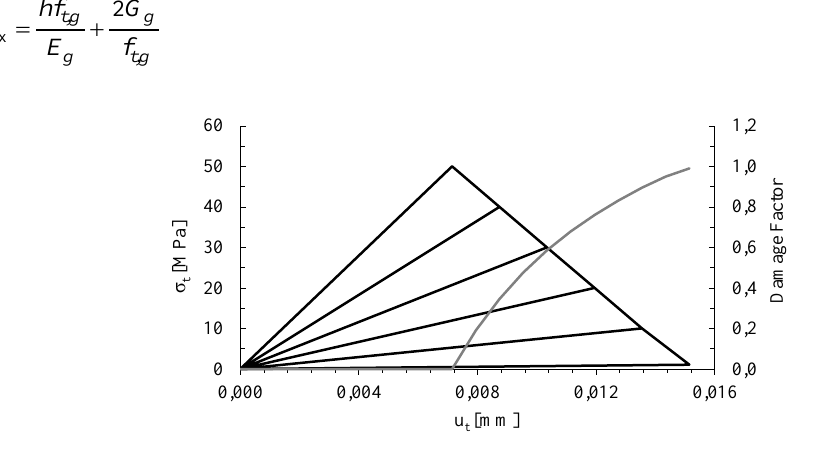
Fig. 2 Damaged law adopted for simulating glass